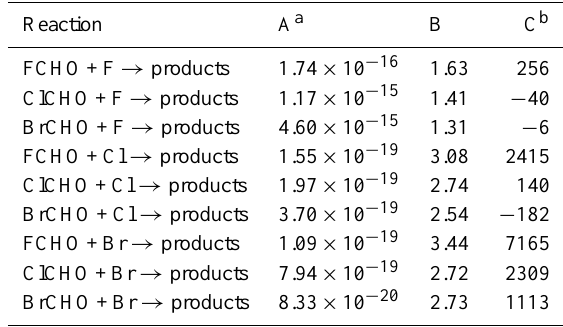
Table 3. The modified Arrhenius formulas for k = AT B exp( − C/ T ) within the temperature range of 200–368K.